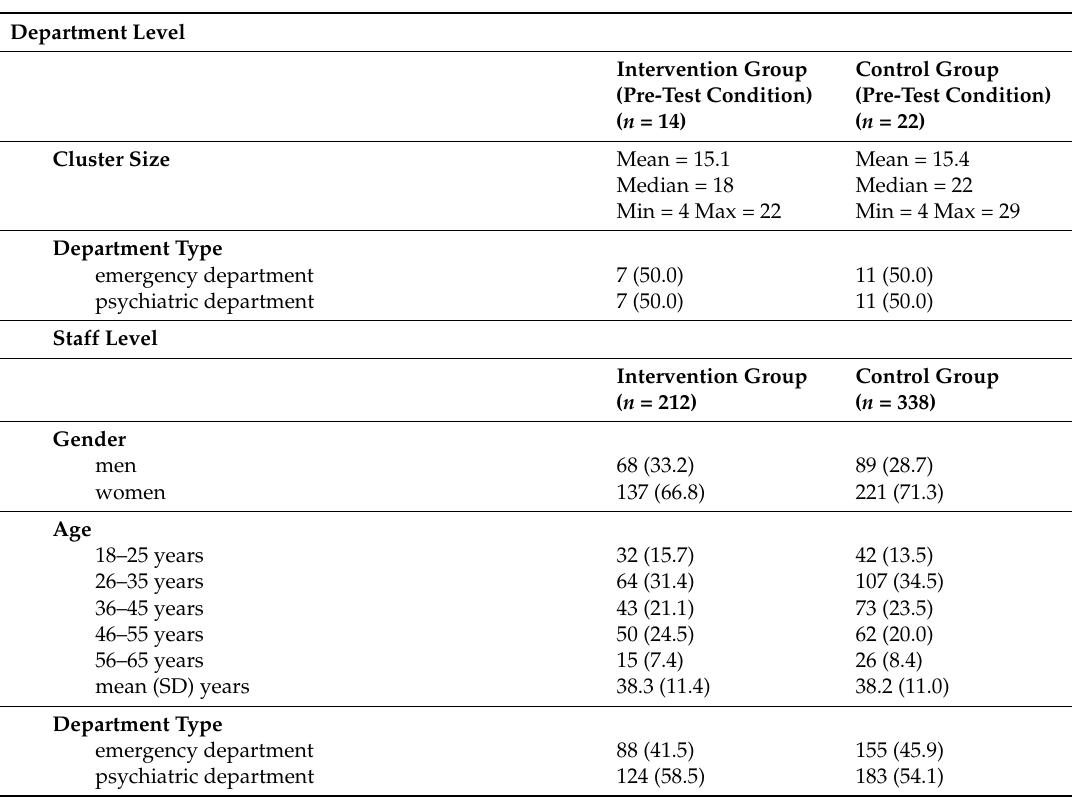
Table 1. Baseline characteristics of the intervention and control group at the cluster level and the individual level in n (%) unless otherwise stated. (Totals do not always equal 212 (intervention group) or 338 (control group) due to missing